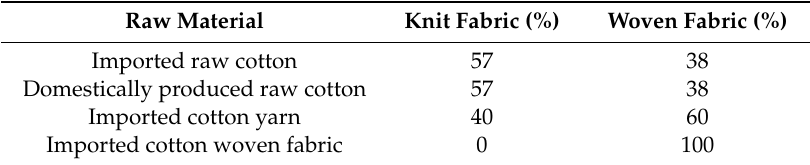
Table A16. Percentage of raw cotton, cotton yarn and cotton woven fabrics in knit and woven fabric manufacturing [24,38,40].